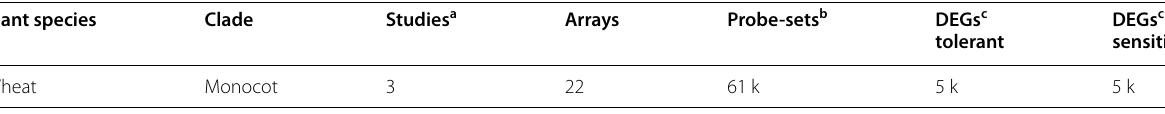
Table 1 Global summary of within species microarray